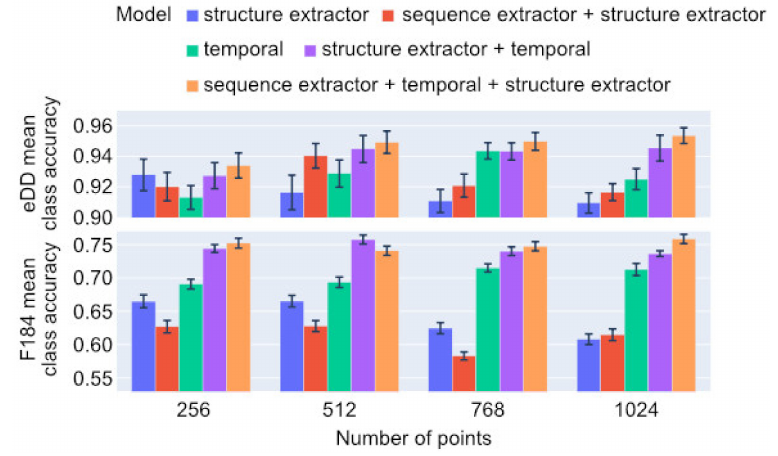
Figure 2. Ablation study on eDD and F184 datasets: mean class accuracy with standard deviation with regard to the number of sampled points using 20 algorithm executions. Table 1. Ablation study: mean class accuracy decreases over various models.